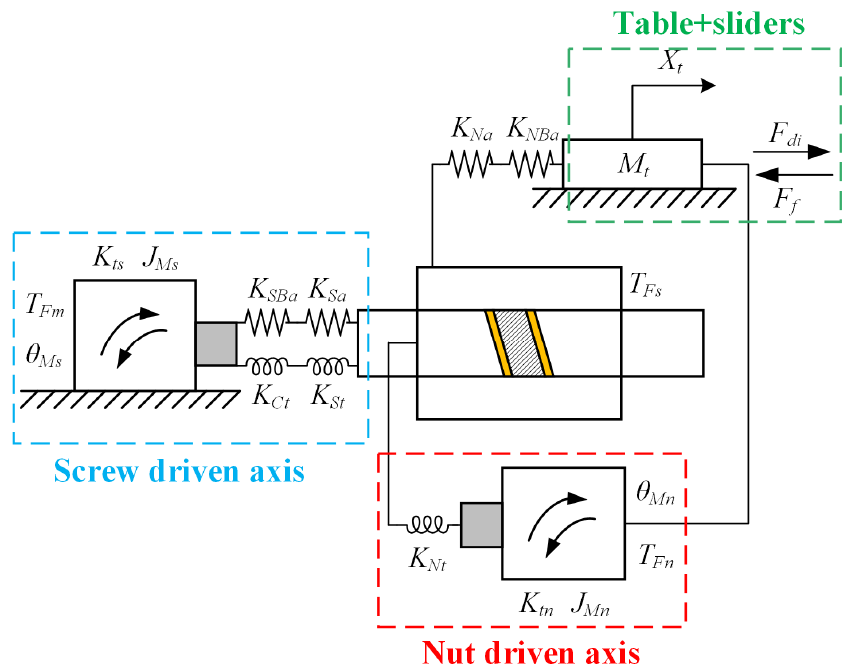
Figure 2. Dynamic modeling of the DDHLS.